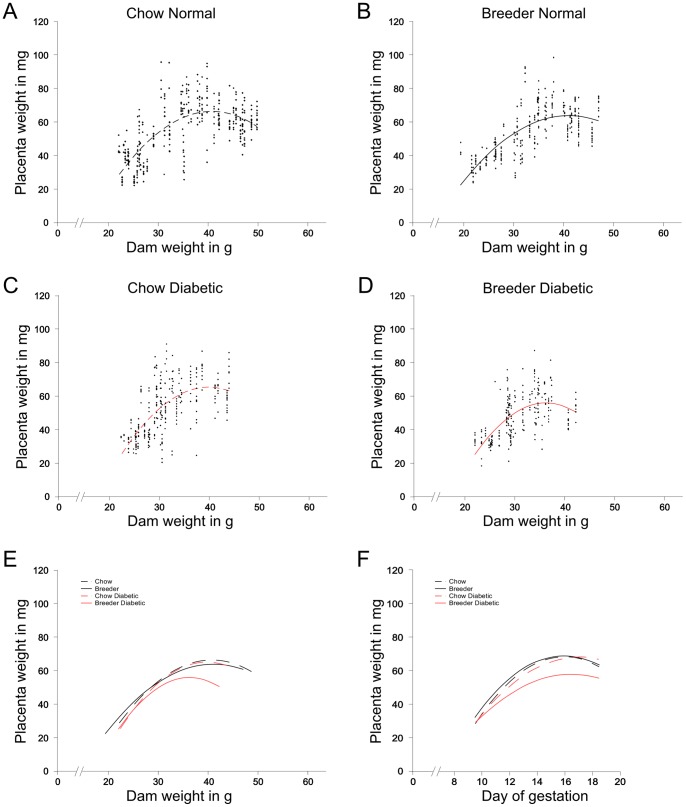
Relationship of placenta size to maternal weight – interaction of diet and diabetes.For each pregnant dam, her weight at sacrifice (timepoints from E9.5 to E18.5) was plotted along the X-axis, and the weights of placentas associated with morphologically normal embryos from her pregnancy were plotted along the Y-axis. Polynomial distributions were fitted to the data for A: Control dams fed chow diet; B: Control dams fed breeder diet; C: Diabetic dams fed chow diet: and D: Diabetic dams fed breeder diet. E: Comparison of the polynomial curves shows that the distribution of placenta weights during the pregnancy is very similar for all groups, except for the group of diabetic dams that were fed breeder diet. F: Comparison of polynomial distributions when the data are plotted by day of placenta isolation. Again, the results for diabetic dams on breeder diet reveal a specific interaction between diet and diabetes on placenta growth.